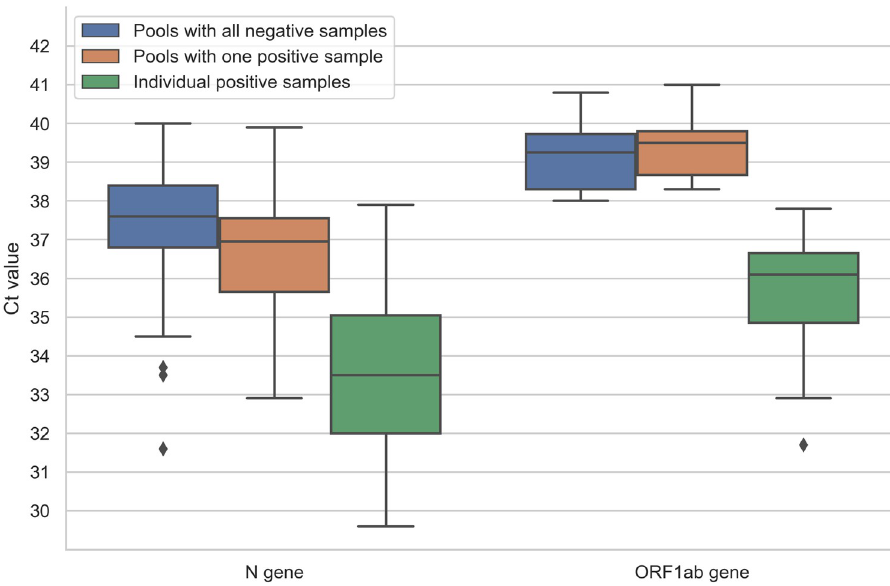
Fig 4. Pools classified as indeterminate. Box plot showing Ct values of N and ORF1ab genes from indeterminate pools which were finally classified as pools constituted by all negative samples (left), pools containing one positive sample (middle) and the individual positive samples after disassembly